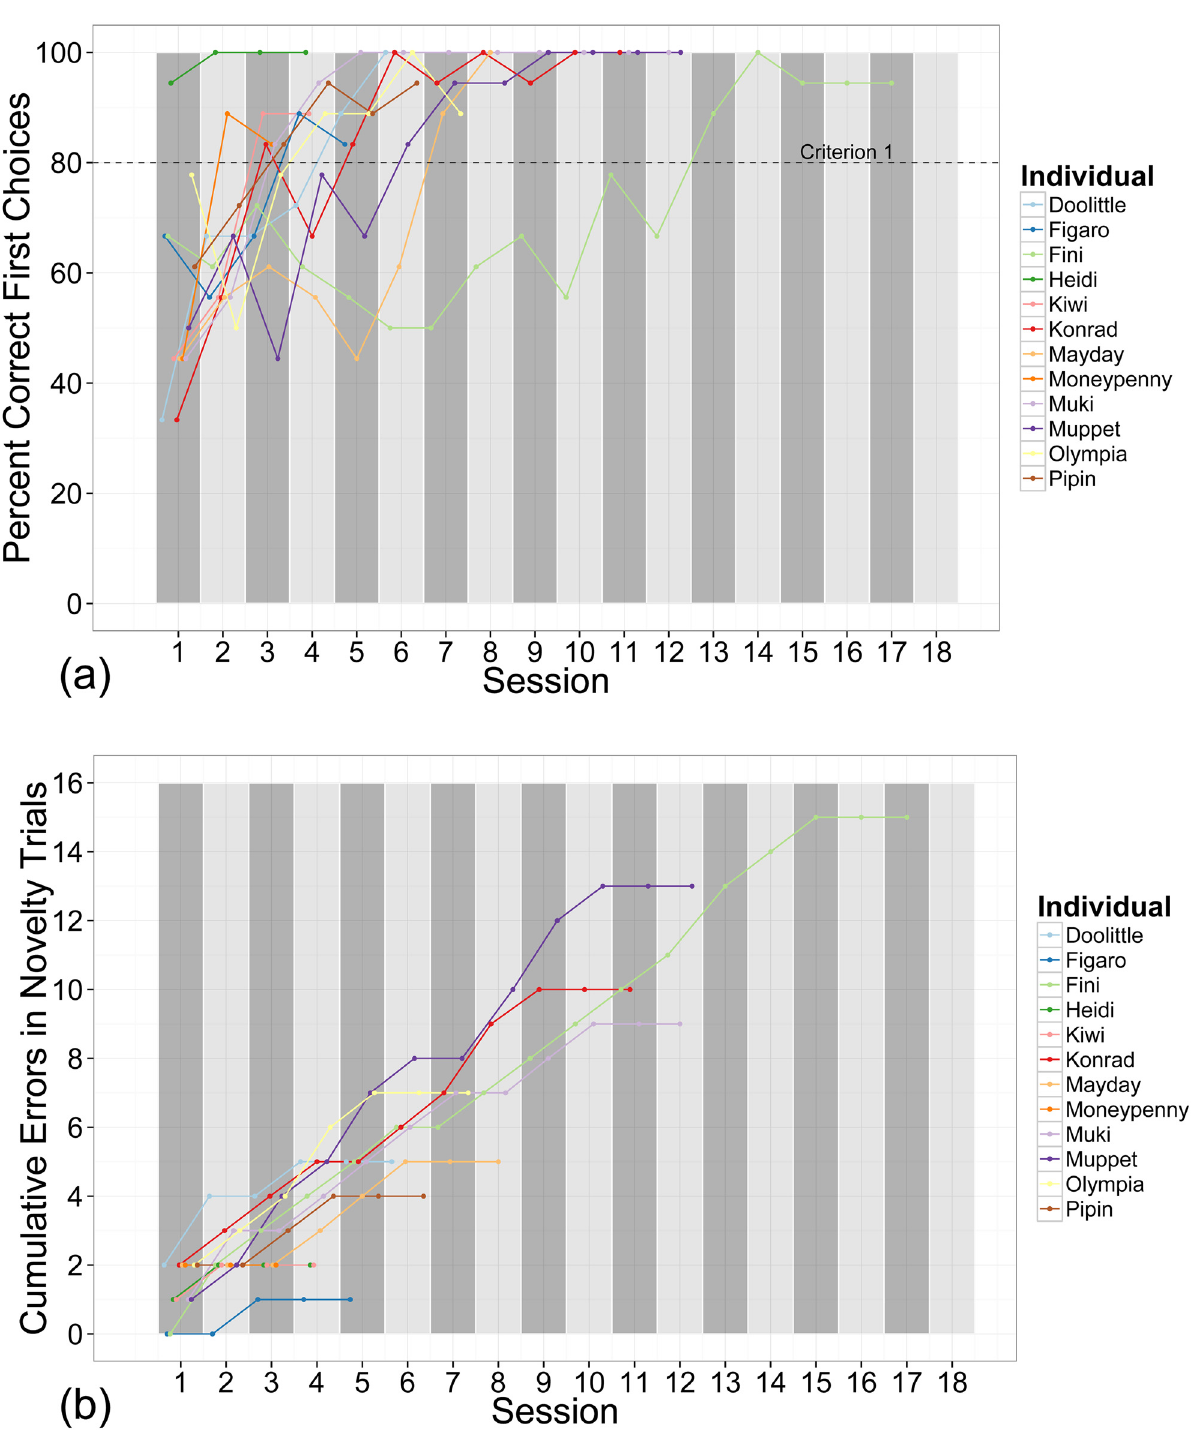
Fig 3. Performance in the training phase. a) Learning curves for all individuals over all training sessions, with the dotted line indicating the learning criterion of 80 per cent correct first choices (Criterion 1); b) Cumulative errors of novelty trials; a steep incline indicates novelty responses in both novelty trials, moderate incline indicates response to one novel stimulus per session and a straight horizontal line indicates no responses towards novel stimuli (Criterion 2); longer lines indicate individuals required more sessions to inhibit responses to novel stimuli.